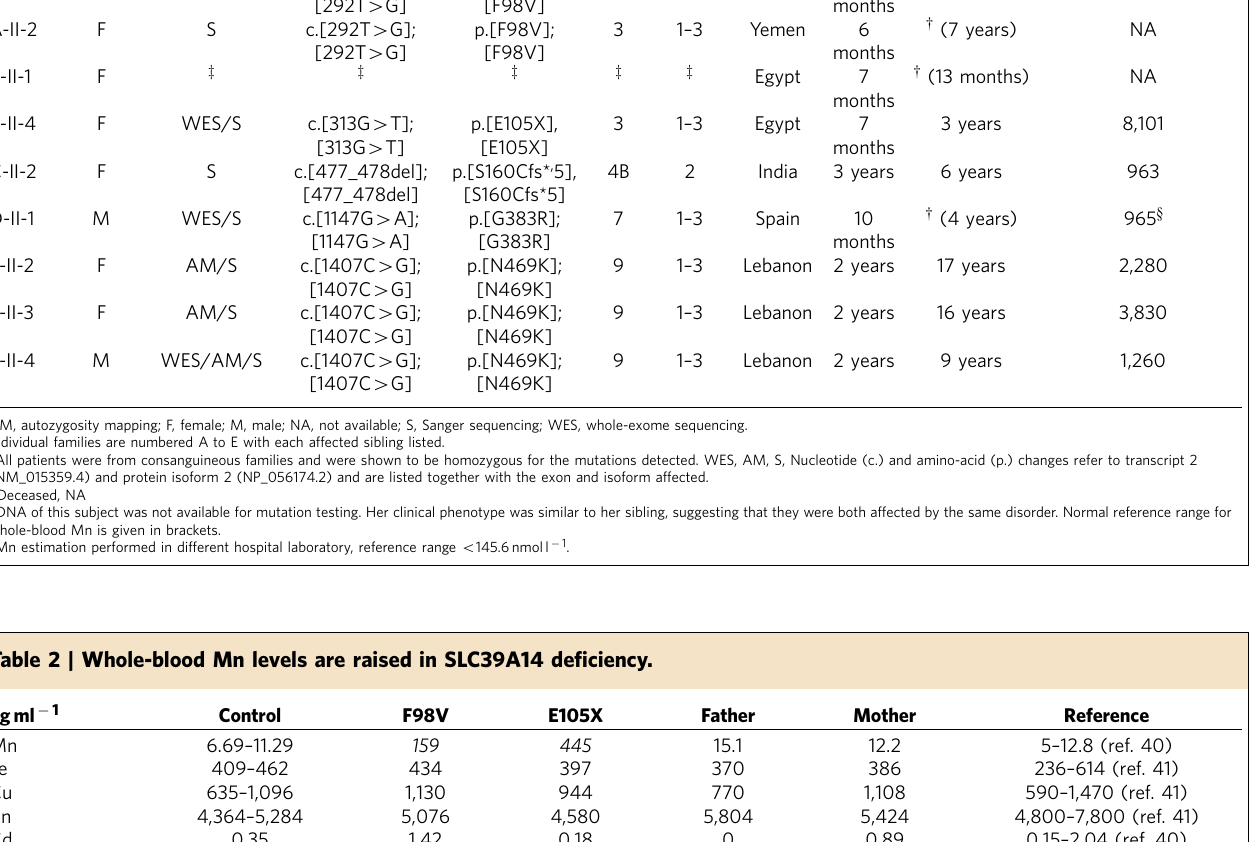
Table showingwhole-blood metal levels for two affected individuals (F98Vand E106X), three healthycontrol subjects, parentsheterozygous for the E105X mutation and published reference ranges 40,41 . While Mn levels are significantly raised in both patients, other metal levels are within the normal range. Abnormal Mn levels are indicated in